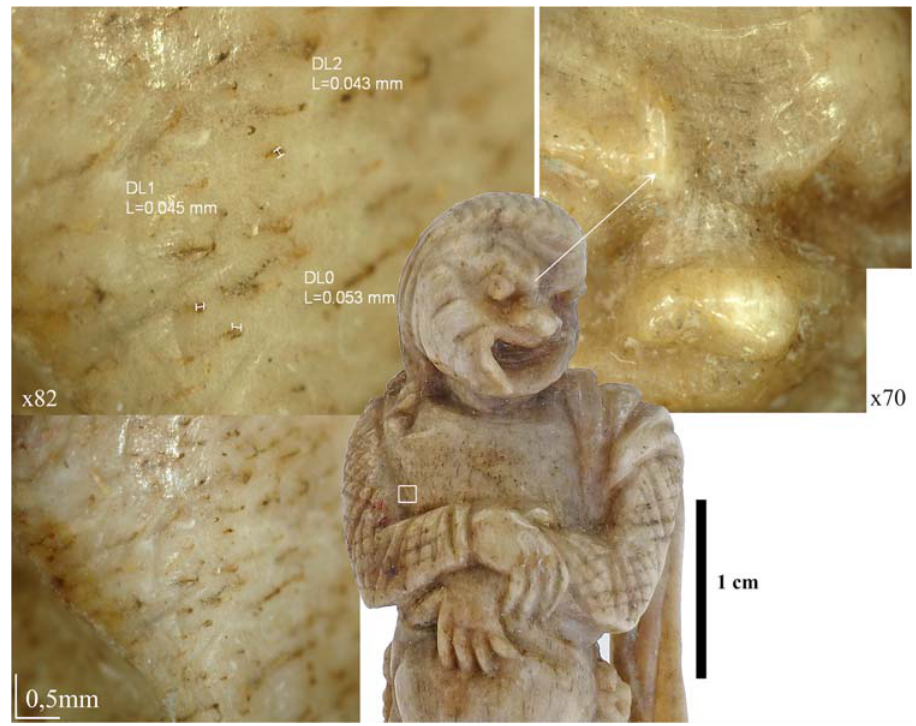
Figure 6: Front view of the upper part of the fi gurine showing natural micro - holes developed within the cortical matrix that evidence the presence of the Haversian/Volkmann ’ s canals ( photos, left ) , and manufacturing marks related to the incising/ scraping techniques with a metallic tool ( right ) . Scale of the fi gurine, 1 cm ( Photo: Éva David )